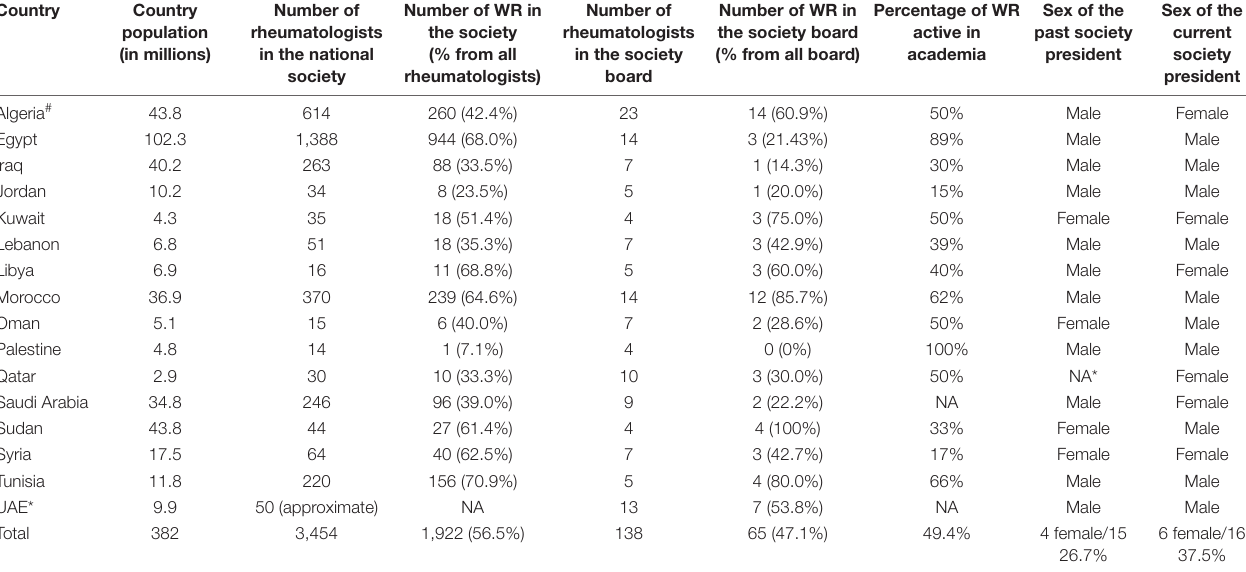
TABLE 1 | Rheumatology workforce in the ArLAR countries. Country Country Number of Number of WR in population rheumatologists the society (in millions) in the national (% from all society rheumatologists)